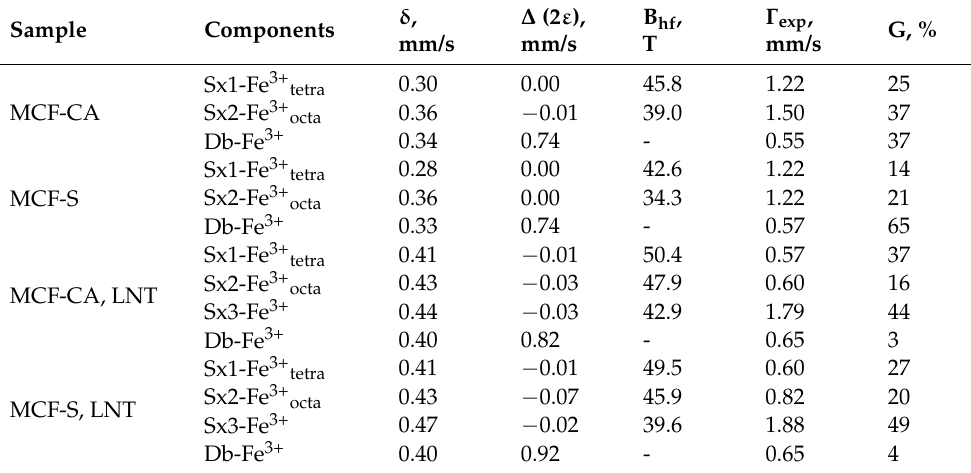
Table 2. Mössbauer parameters for MnCoFeO 4 samples obtained using two types of fuels.